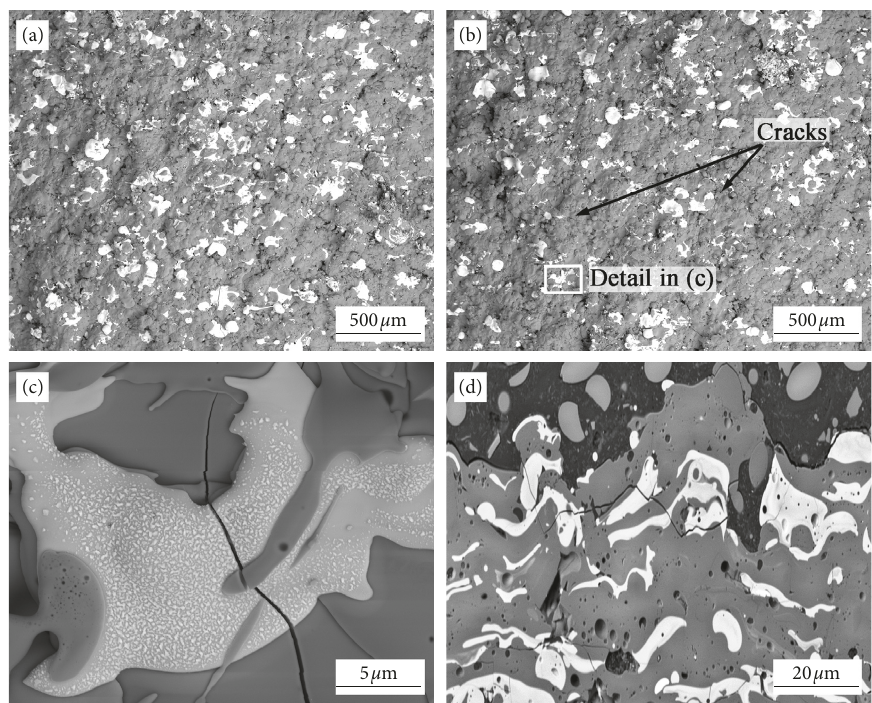
Figure 3: Surface morphology of TEBC coating in (a) as-coated conditions, (b) after the heating and cooling cycle, and (c, d) detail showing cracks after heating and cooling cycle.